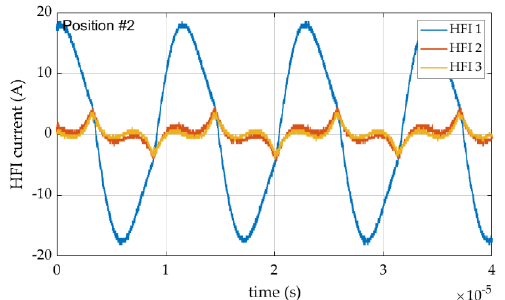
Figure 18. HFIs output currents with full coupling with the first track coil (Position #2).